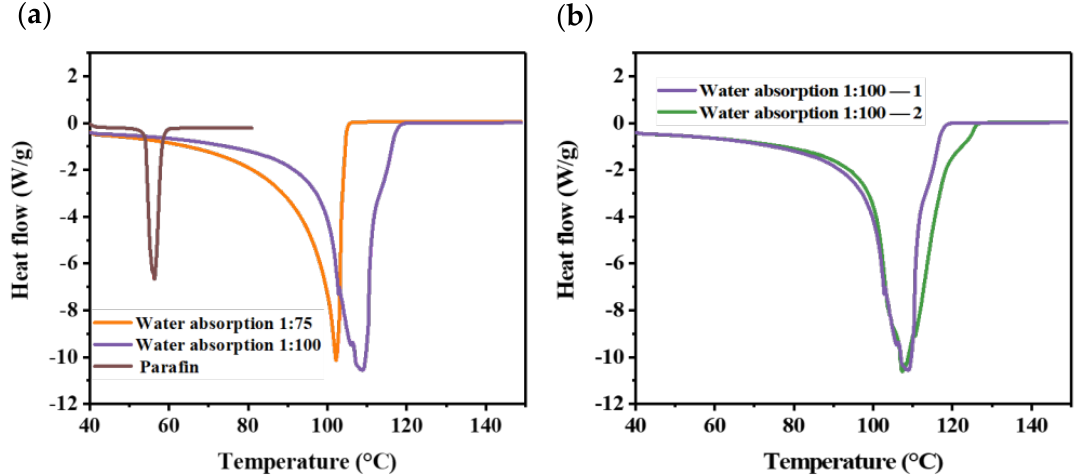
Figure 3. DSC test of hydrogel: ( a ) hydrogel compared with paraffin; ( b ) repeatability check.